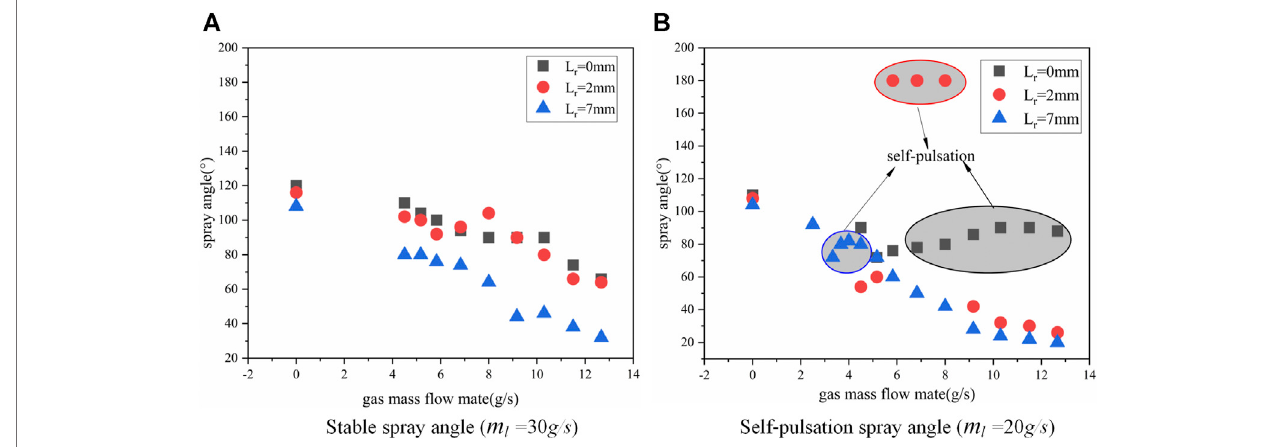
FIGURE 8 | In fl uence of recess on spray angle. (A) Stable spray angle ( m l (cid:2) 30 g/s ). (B) Self-pulsation spray angle ( m l (cid:2) 20 g/s ).